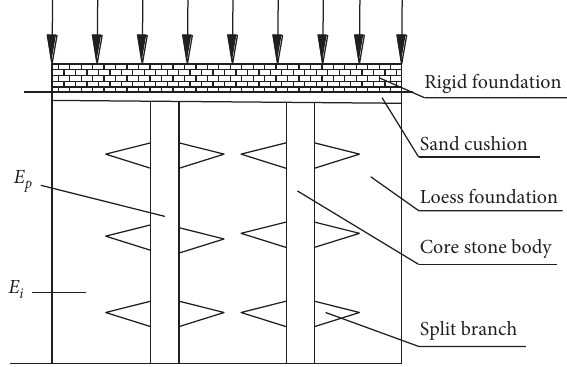
Figure 2: Split grouting pile composite foundation.